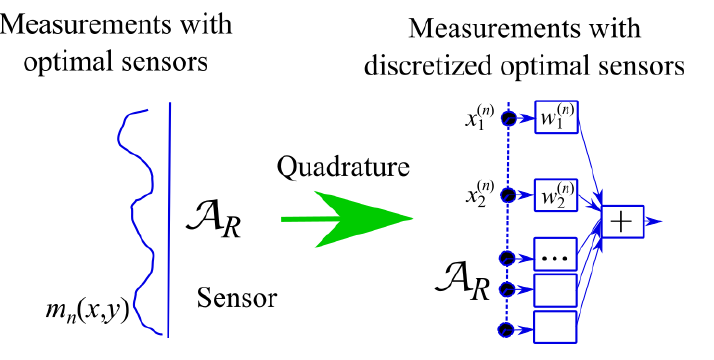
Figure 4. Illustrating the representation of the “optimal virtual” sensors by arrays thanks to the use of generalized Gaussian quadrature